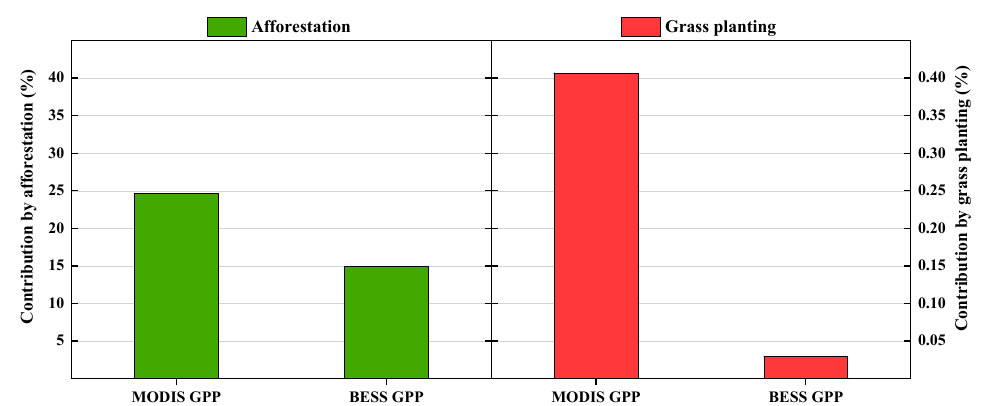
Figure 8. Contributions of afforestation and grass planting to the actual GPP increase in afforestation and grass planting areas during the period of 2001–2015. Table 2. ERP-driven (afforestation and grass planting) and actual GPP trends from 2001 to 2015. Area